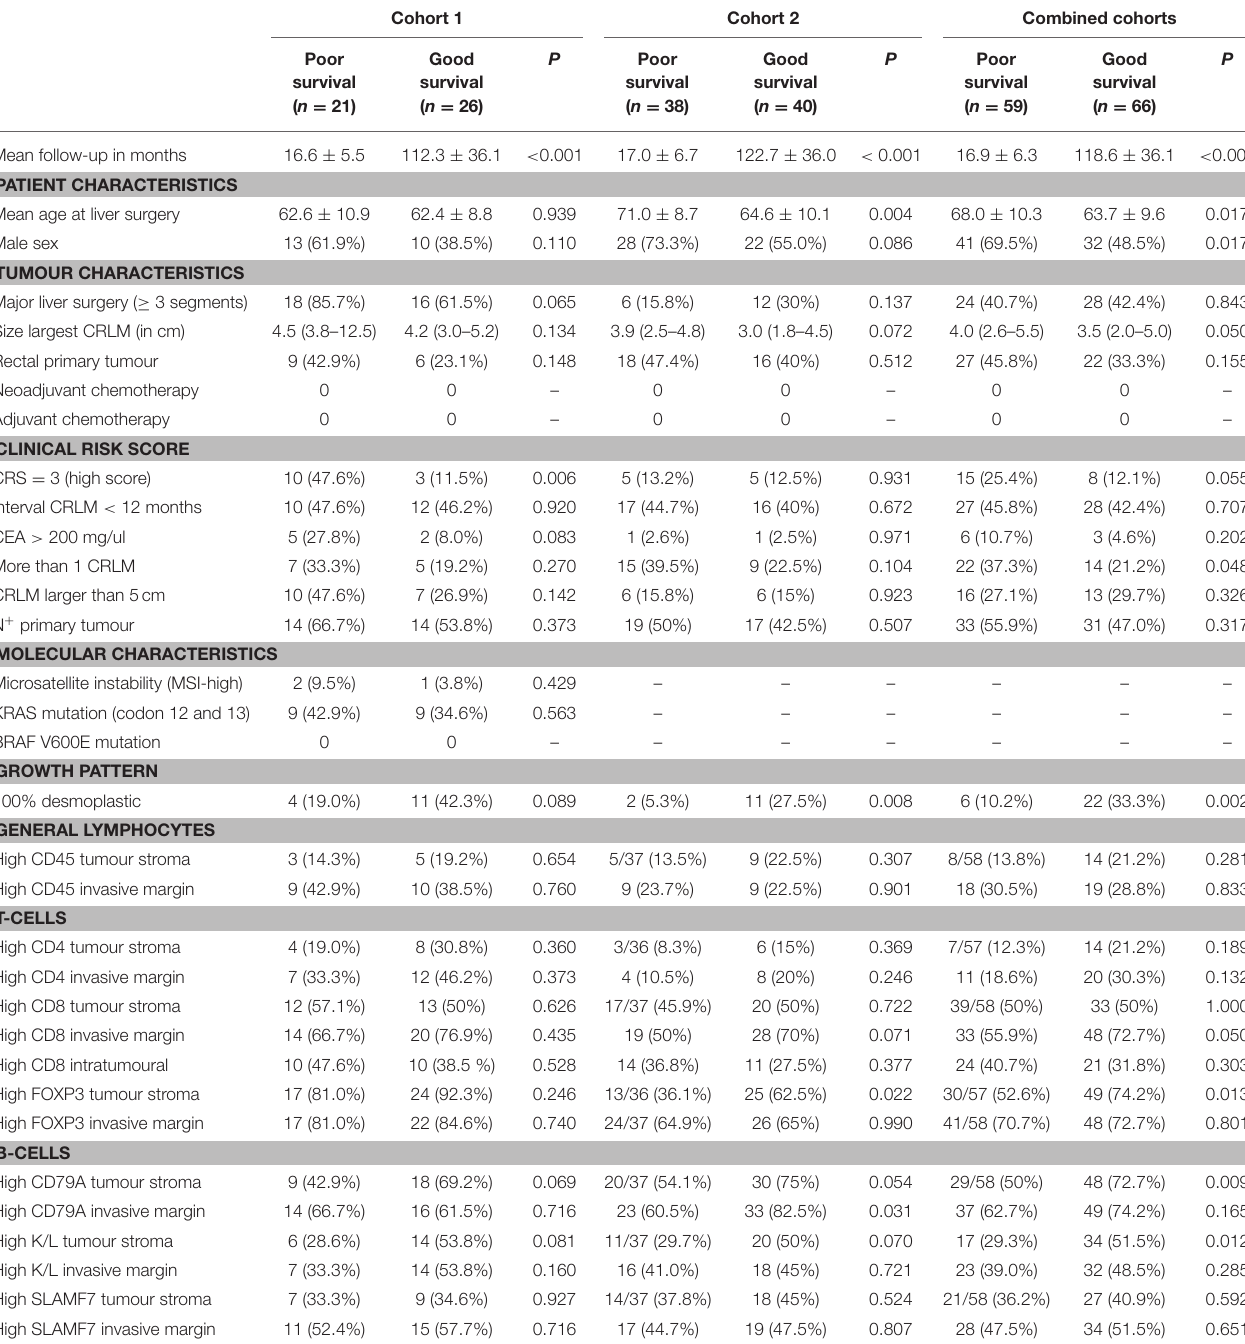
TABLE 2 | Clinicopathological and biological markers vs. survival in cohorts 1, 2 and